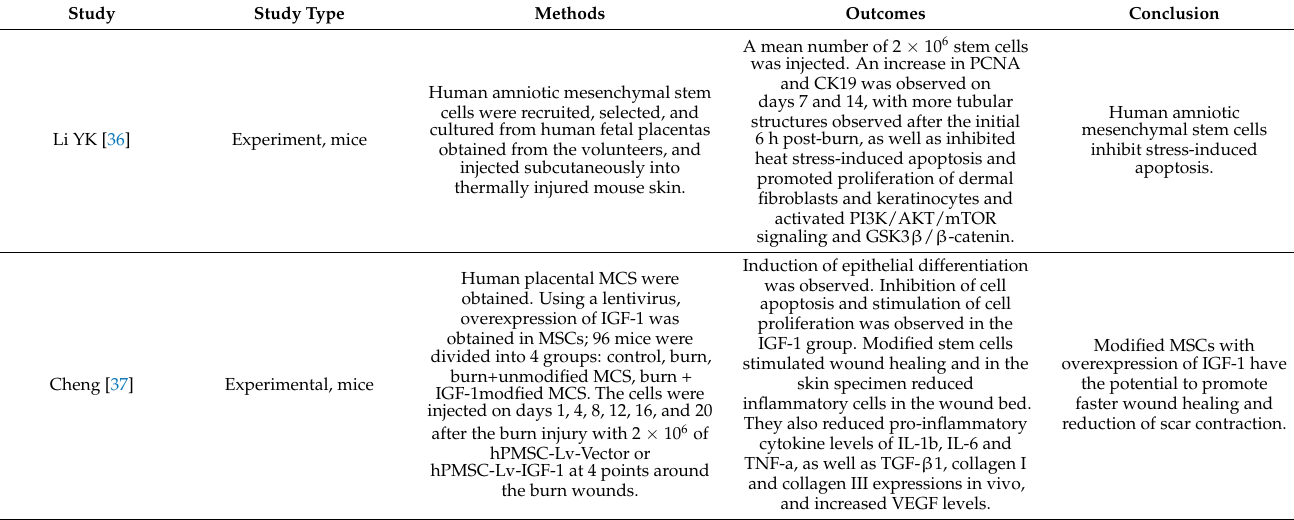
Table 1. Experiment studies on animal models on the use of stem cells in burn wound